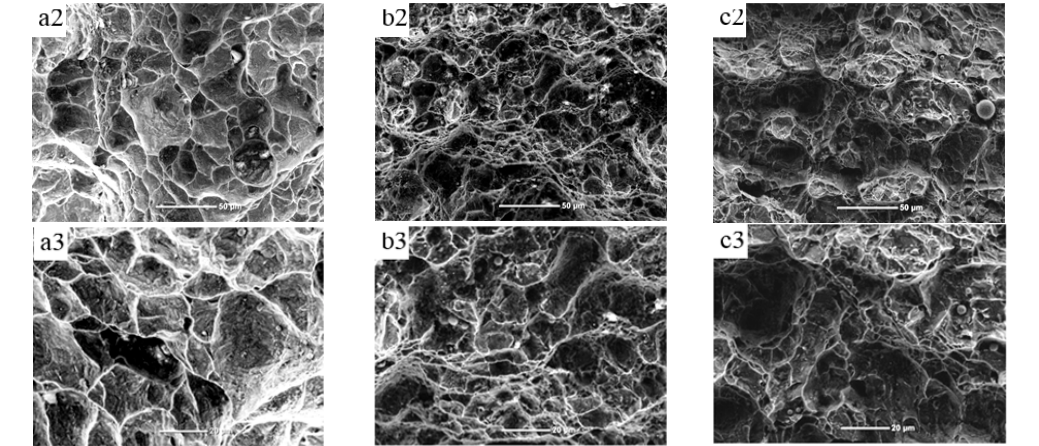
Figure 7. Scanning electron microscope (SEM) images of fracture with different magnifications for TA15 alloy after ( a1 ) high temperature tensile test (×27); ( a2 ) high temperature tensile test (×500); ( a3 ) high temperature tensile test (×1000); ( b1 ) room temperature tensile test (×27); ( b2 ) room temperature tensile test (×500); ( b3 ) room temperature tensile test (×1000); ( c1 ) impact test (×27); ( c2 ) impact test (×500); ( c3 ) impact test (×1000).